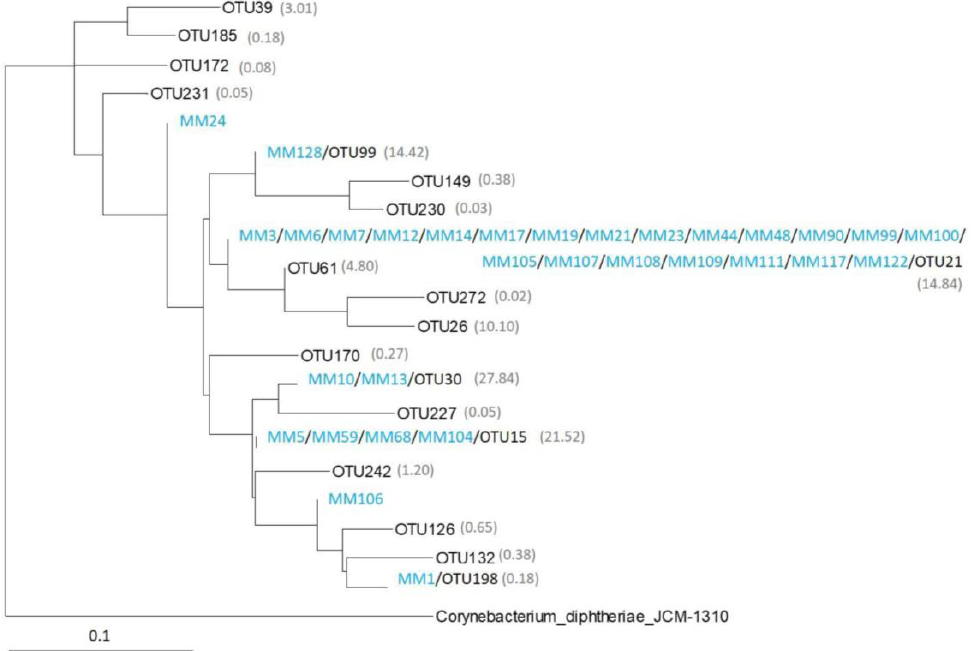
Figure 4. Phylogenetic relationships between culturable and non-culturable Streptomyces originating from moonmilk of “Grotte des Collemboles”. The tree was inferred by maximum likelihood. Scale bar is in substitution per site. Numbers between brackets reflect the predicted mean abundance of Streptomyces OTUs in the studied deposits based on the percentage of sequences retrieved from the HTS analysis. Streptomyces phylotypes isolated in our previous bioprospection study (MM strains) are marked in blue.